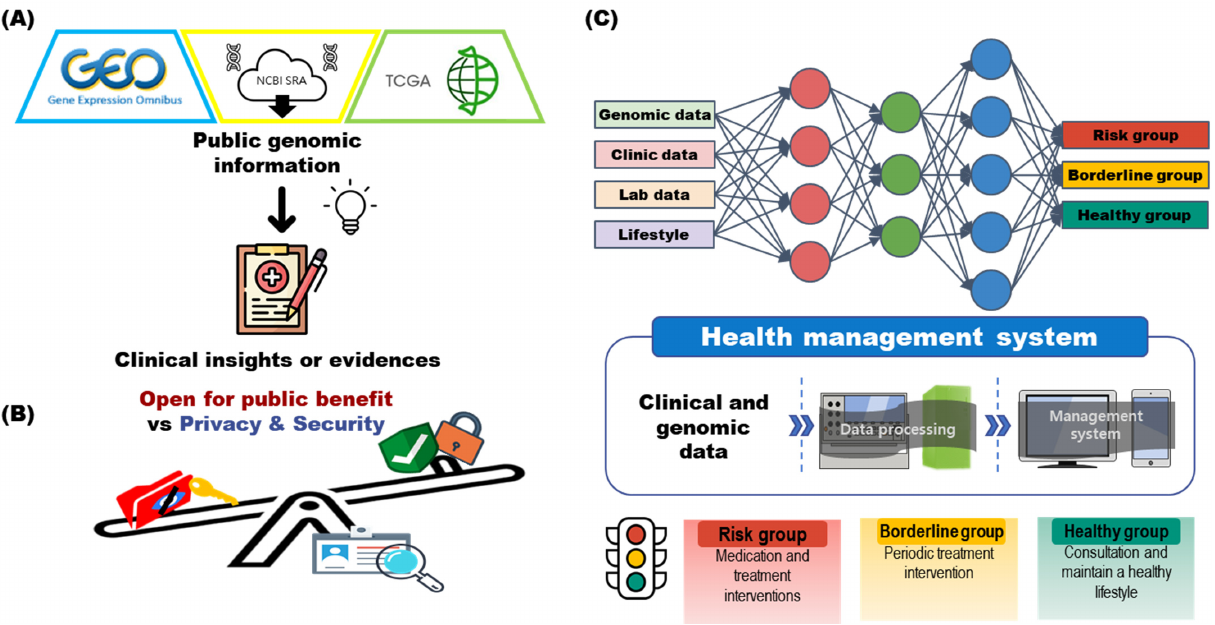
Figure 4. Example of an ideal genomic information management system (GIMS). ( A ) Many public omics data are deposited in NCBI GEO, NCBI SRA, and TCGA. These can be used as reference data for analyzing omics data to be produced in the future and can help discover clinical insights or evidence. ( B ) When using omics data, a compromise must be found between the disclosure of information for public benefit and maintaining the privacy and security of patients and participants. ( C ) In the GIMS, individual genomic, clinical, laboratory data, and questionnaire-based diet and exercise information can be classified into risk, borderline, and healthy groups using machine learning. This can be generalized and used as a health management system and can facilitate the assessment of the need for treatment intervention, as well as aid the provision of lifestyle-related suggestions for maintaining a healthy state.